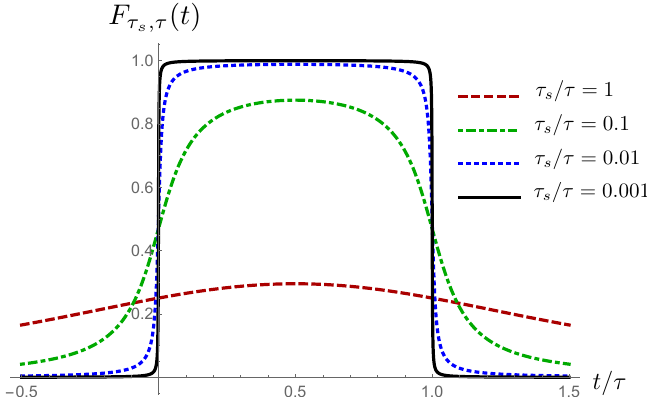
Figure 8 . Behavior of F (cid:28) s ;(cid:28) ( t ) given by eq. (A.1) for some representative value of (cid:28) s =(cid:28) . Here the sudden switching regime is achieved when (cid:28) s =(cid:28) 0. The switching function described by F ( n ) (cid:28) ( t ) ! presents a quite similar behavior, but with the sudden switching being approached in the regime of n (cid:29)